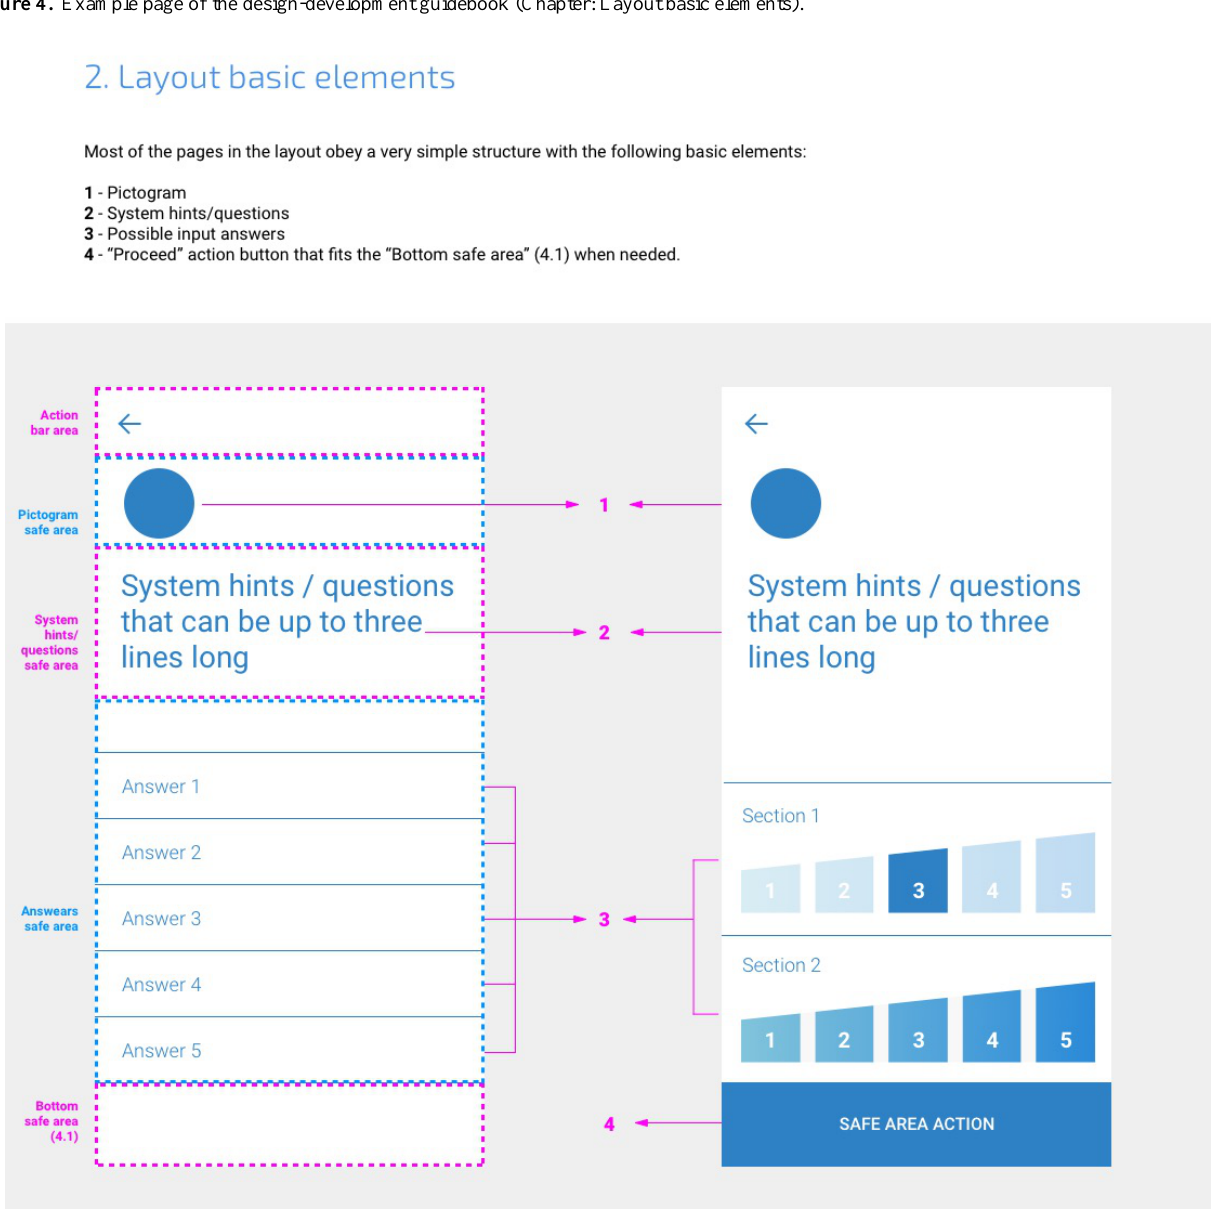
Figure 4. Example page of the design-development guidebook (Chapter: Layout basic